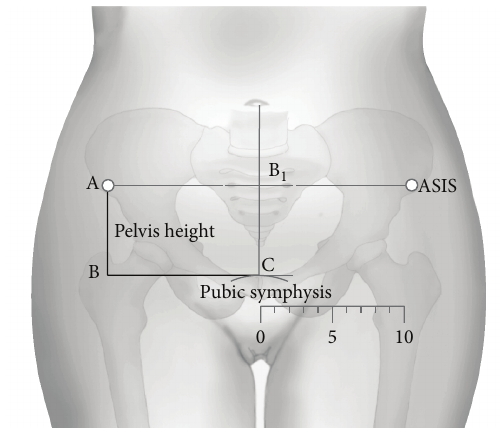
Figure 1: Measurement of pelvis height.